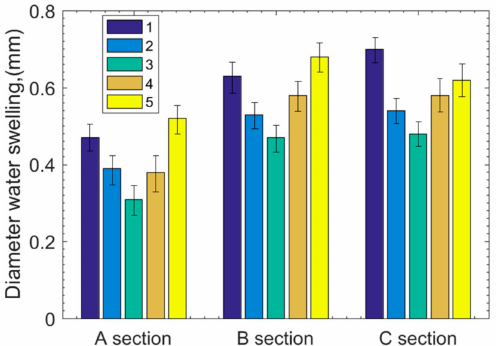
Figure 6. Diameter reduction before and after soaking for 6 months.